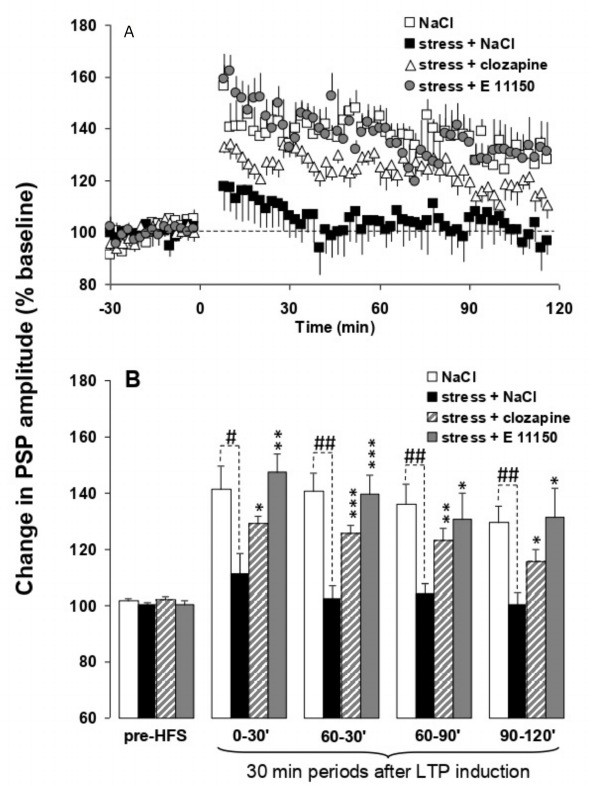
Figure 6. Comparison of the effects of EGIS 11150 and clozapine on stress-induced impairment of hippocampal-prefrontal cortex LTP in vivo. Panel ( A ) EGIS 11150 administered at 0.01 mg/kg and clozapine at 0.3 mg/kg after stress, 40 min prior to HFS enables the induction of LTP in stressed rats when compared to saline-pretreated stressed rats. Values are mean ± SEM of the normalized postsynaptic potential (PSP) amplitude. Panel ( B ) LTP in saline, EGIS 11150 and clozapine pretreated stressed rats represented at different time periods. PSP amplitudes were analysed using A/Dvance software, expressed as a percentage change of the mean response over a 30 min baseline period and presented in figures as the mean ± SEM for 2 min epochs. Electrophysiological data were averaged in consecutive 30 min periods (T0–30 min, T30–60 min, T60–90 min, T90–120 min) after LTP induction. Statistical comparisons were carried out using analysis of variance [19]. The first and following groups of columns represent 30 min periods of mean ± SEM of the normalized PSP amplitude before, and after HFS. ANOVA: * p < 0.05 ** p < 0.01 and *** p < 0.001 vs. saline-treated stressed rats, ANOVA: # p < 0.05, ## p < 0.01, vs. saline-treated stressed